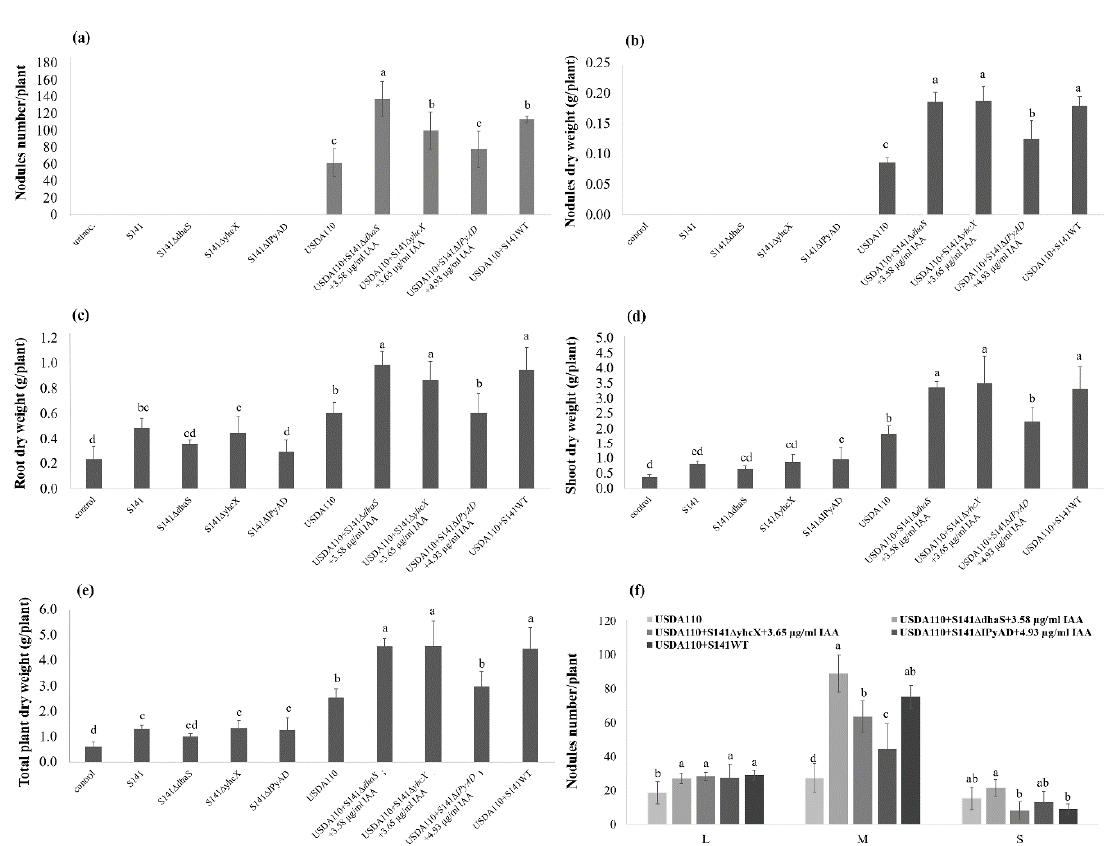
Figure 9. Plant growth parameters of soybean cultivar Chiang Mai 60 by co-inoculation with USDA110 and S141 or S141 mutant strains complemented with Indole-3-Acetic Acid compared with single inoculation at 45 DAI: ( a ) nodule numbers per plant; ( b ) nodule dry weight; ( c ) root dry weight; ( d ) shoot dry weight; ( e ) total plant dry weight; and ( f ) nodule size separation. Significance at p ≤ 0.05 is indicated by mean standard error bars (n = 6 ).